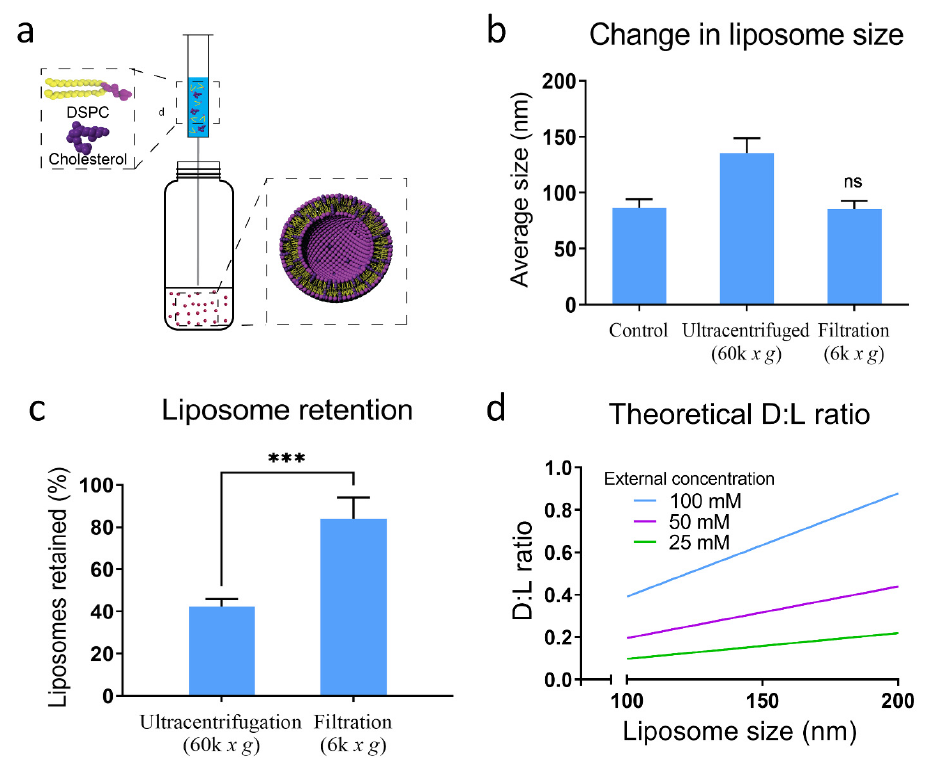
Figure 1. Synthesis of potent targeted liposomes. ( a ) Liposomes are synthesized in a rapid and scal- able manner using the injection method. Membrane components are dissolved in isopropyl alcohol and injected into DI water at 55 ° C. The phase change causes the arrangement of liposome compo- nents to form small unilamellar liposomes. The solution is concentrated 20× using filter centrifuga- tion. ( b , c ) The filtration process retains the population of liposomes efficiently, as seen in the size distribution and lipid concentration. The liposome population increases in diameter from ~80 nm to ~135.4 nm when ultracentrifuged as a result of small liposomes remaining in the supernatant. The change in diameter when filtered was not statistically significant, suggesting the relative population was retained. Analysis of lipid concentration showed nearly 60% of the liposomes were lost follow- ing ultracentrifugation, whereas filtration retained 84% of the total liposomes in solution. ( d ) The theoretical D:L ratio of thermal equilibration for hydrophilic molecules is dependent on liposome diameter and initial drug concentration, where increasing liposome diameter and external concen- tration results in an increase in liposome